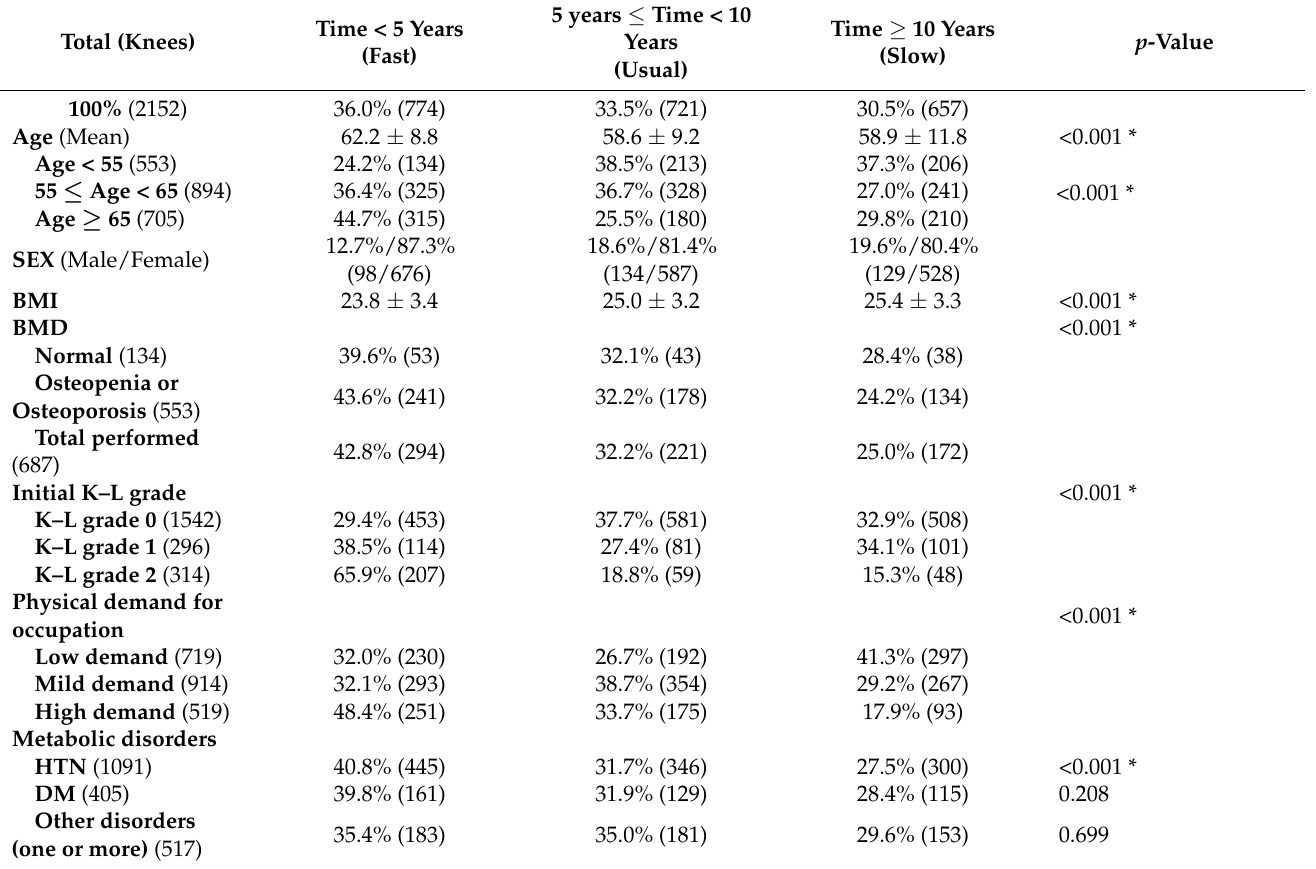
Table 2. Comparison of affecting factors according to the progression rate of